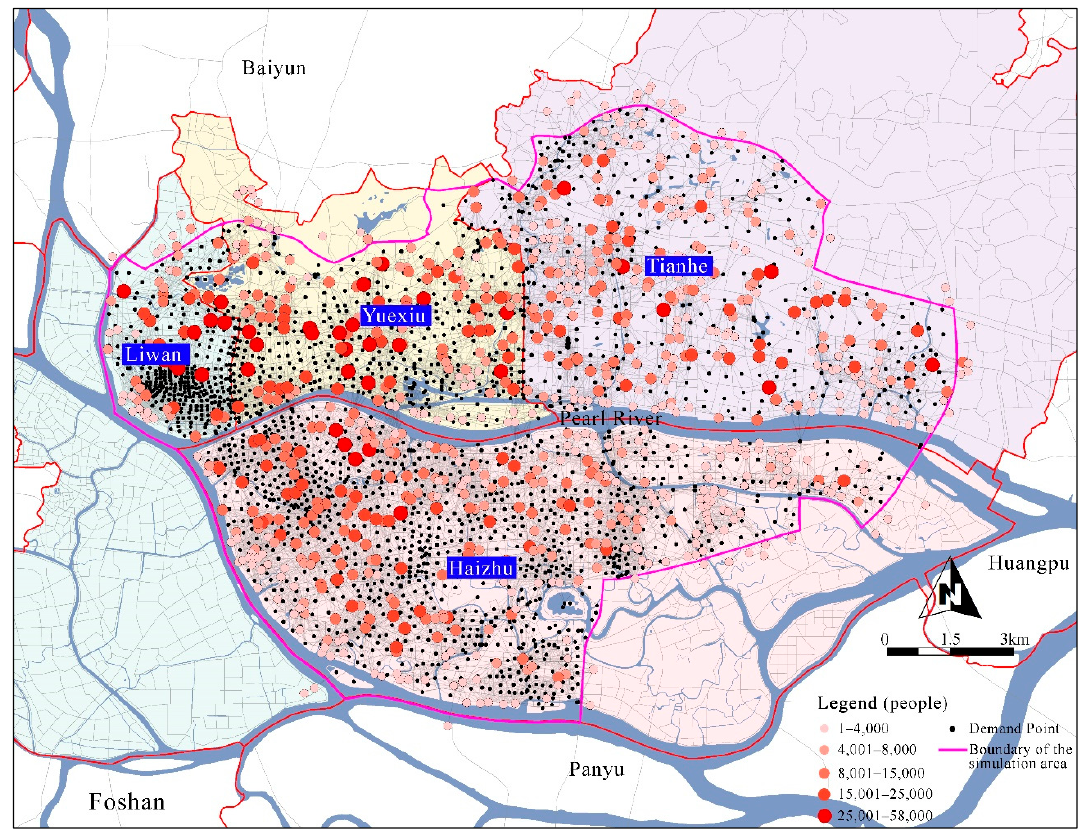
Figure 8. Distribution of evacuees accepted in shelters after the simulation.